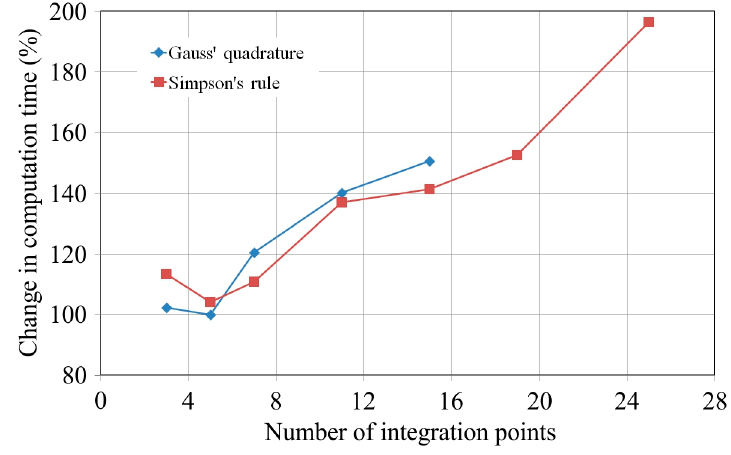
Figure 5. Change of computational time with a number of integration points for Gauss’ quadrature and Simpson’s rule. Metals 2017 , 7 , 380